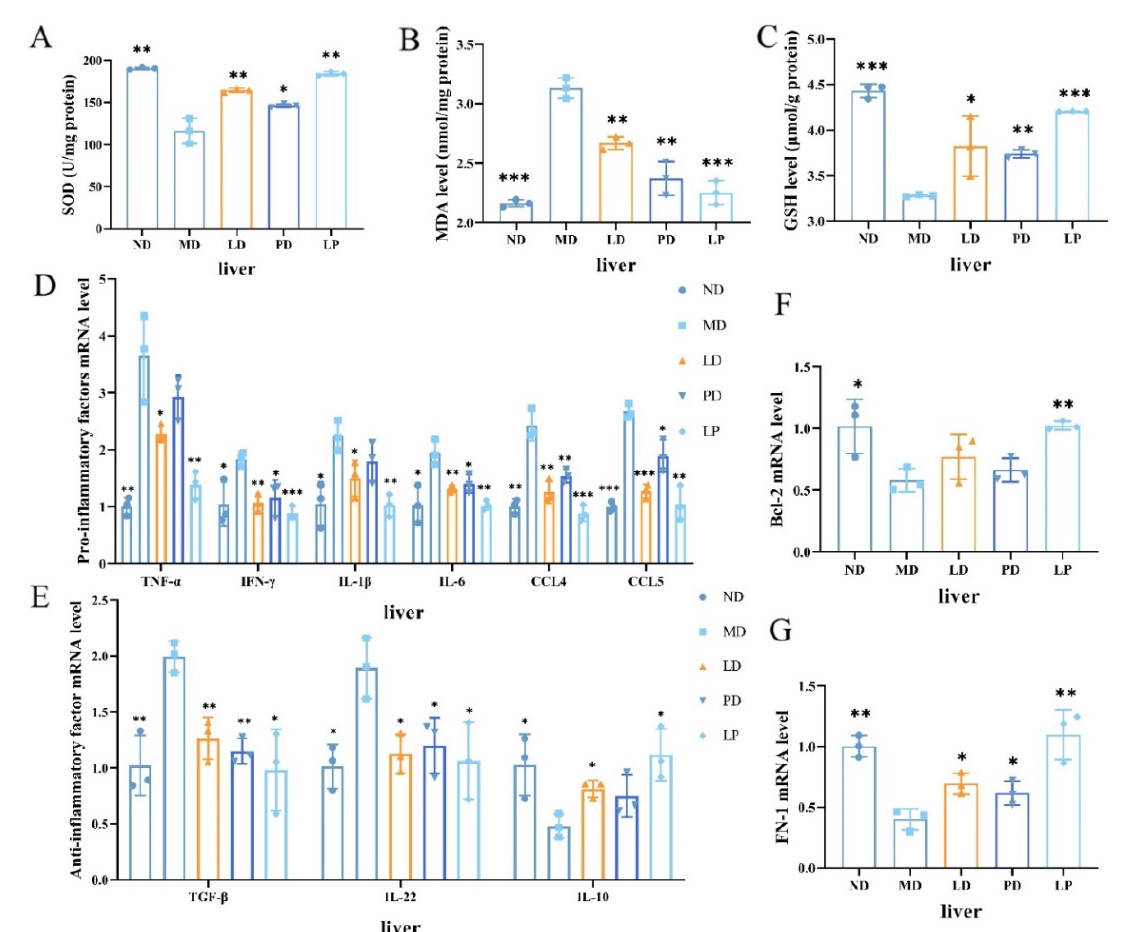
Figure 3. Synbiotics reduced oxidative stress and relieved liver inflammation in CCl 4 -induced ALI mice. ( A – C ) Homogenizing the liver tissues to examine the activities of SOD ( A ), the MDA ( B ), and GSH content ( C ) ( n = 3). ( D ) the expression levels of IFN- γ , IL-1 β , TNF- α , IL-6 and Chemokines (CCL4, CCL5) ( n = 3). ( E ) the expression levels of anti-inflammatory factors (IL-10, IL-22, TGF- β ). ( F , G ) the mRNA level of Bcl-2 ( F ) and FN-1 ( G ) ( n = 3). * p < 0.05; ** p < 0.01; *** p < 0.001; * is compared with MD; paired two-tailed t -test.